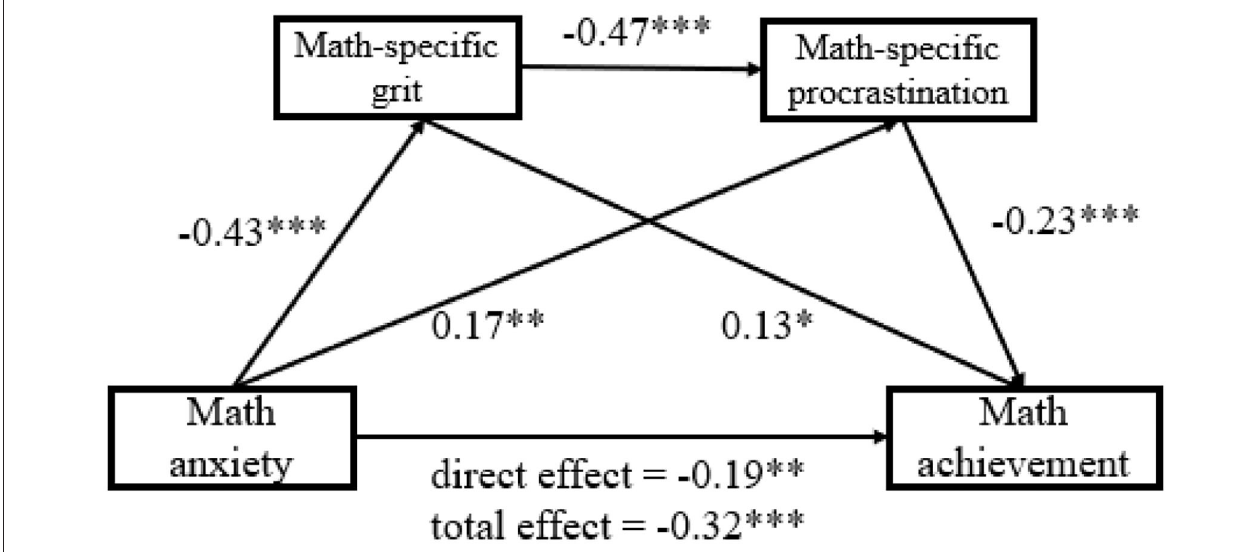
FIGURE 2 | Sequential mediation model of math anxiety as a predictor of math achievement mediated by math-specific grit and math-specific procrastination. Standardized regression coefficients are displayed for all paths. *** p < 0.001; ** p < 0.01; *p <